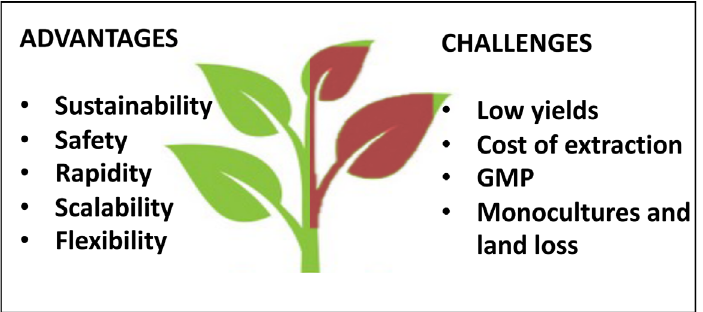
Figure 2. Advantages and disadvantages of plant molecular farming.